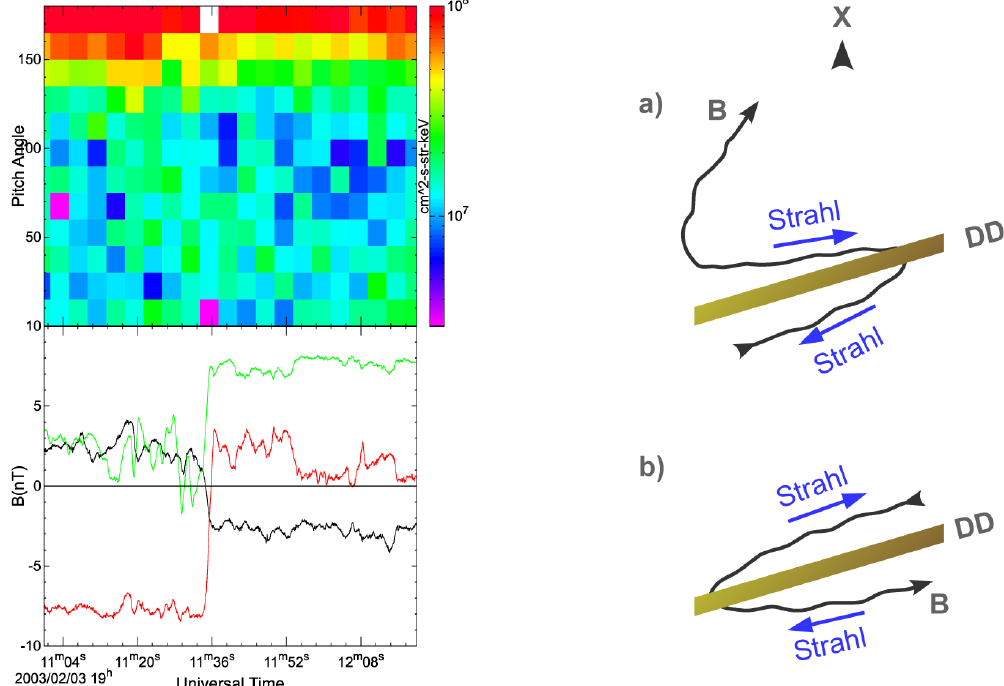
Fig. 11. Left: Color-coded Cluster C1 electron pitch-angle distribution and high-resolution magnetic field components across the 2003-034- 1911 DD. The strahl peaks at 180 ◦ pitch angle on both sides. The white pixel right at the DD crossing time indicates even higher fluxes than those in the adjacent red ones. Right: Sketch (a), connecting the fields on the two sides such that B n > 0, shows an overall configuration that is consistent with all we know about the case; if one connects the fields such that B n < 0, as shown by Sketch (b), one ends up with a configuration that is totally inconsistent with the facts; in particular it has the strahl directed sunward. The Sun is in the direction of the x-arrow.